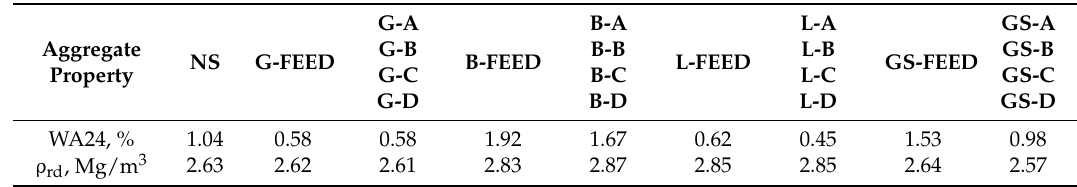
Table 4. Water absorption and dry density results.